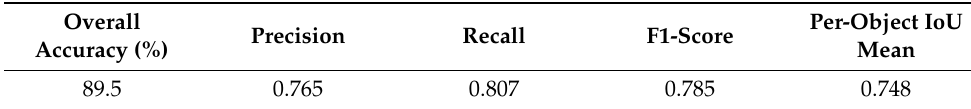
Figure 7. Buildings segmentation results: ( a ) single-family detached buildings, ( b ) multi-family building-blocks. Table 1. Building outlines’